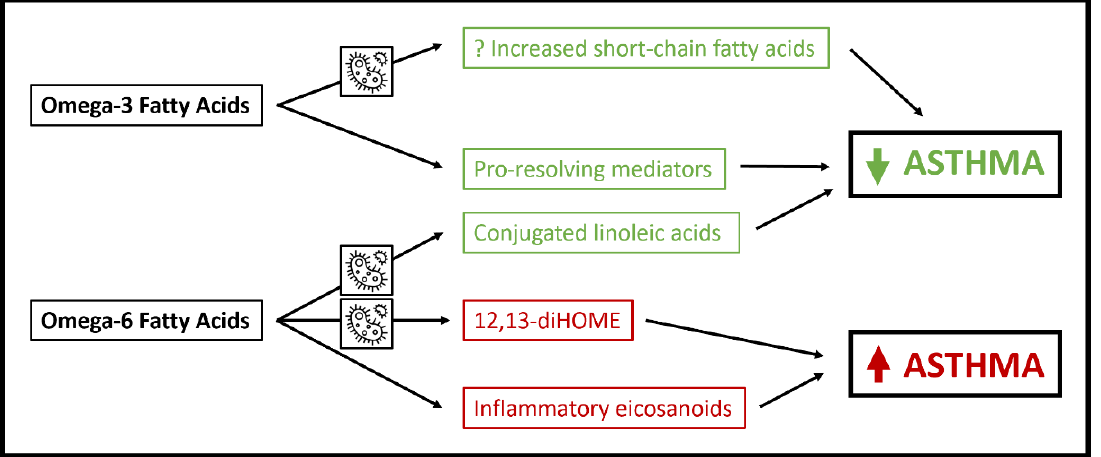
Figure 1. Schematic of mechanisms whereby polyunsaturated fatty acids may influence asthma pathophysiology. Pathways in which microbial metabolism is essential are highlighted by the microbe